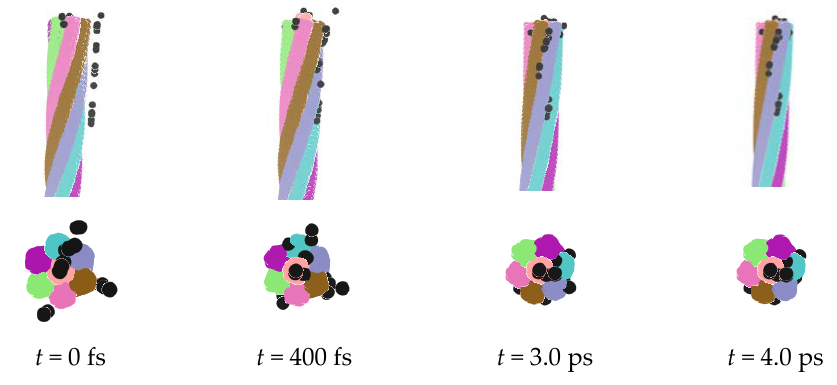
Figure 3. Adsorption of negative ions.